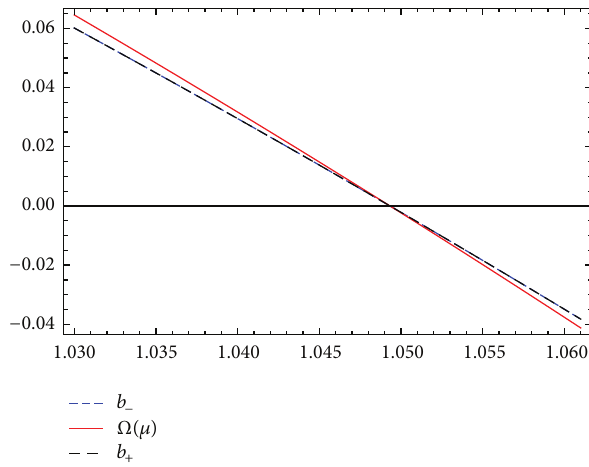
Figure 2: The enclosure interval dominating 𝜇 1 for 𝑚 = 10 , 𝑁 = 15 , 𝜃 = 1/5 , and 𝜀 = 10 −10 .